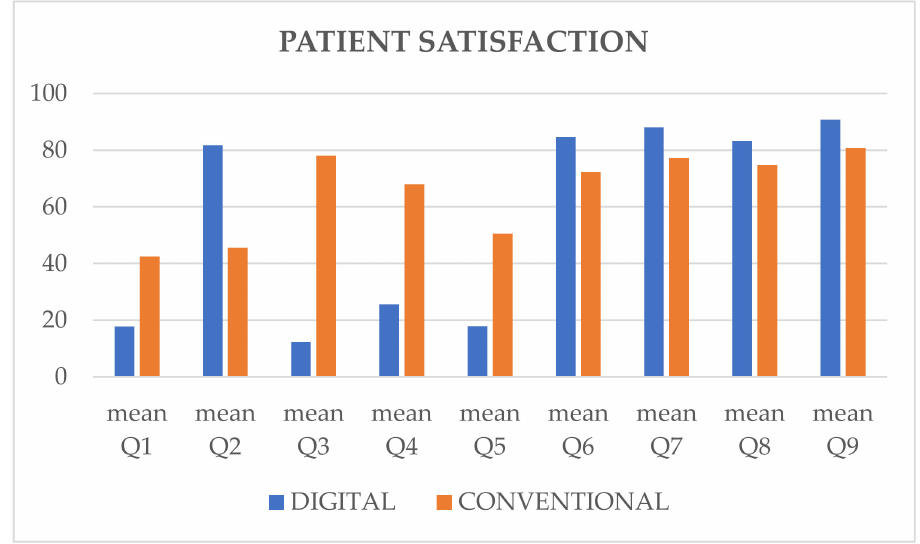
Figure 5. Mean scores of patient-centered outcomes with digital and conventional